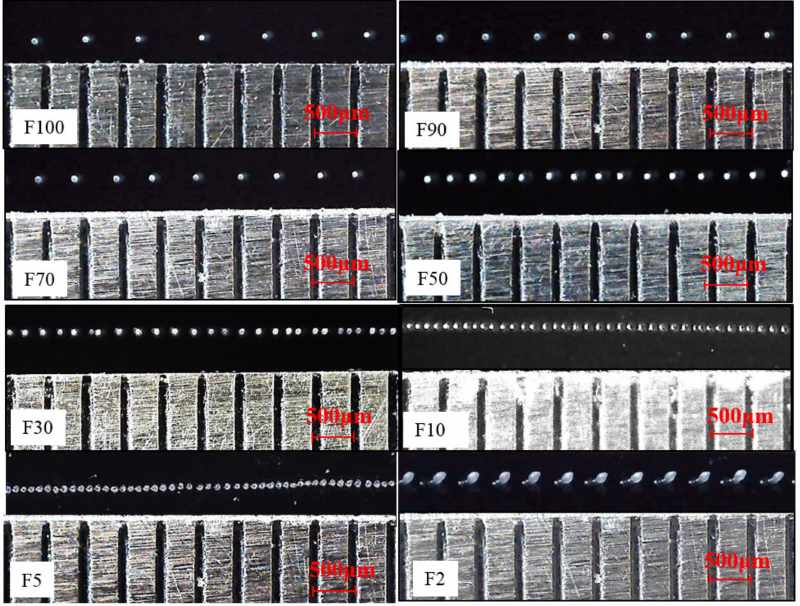
Figure 10. The morphology of the deposited lines at different movement